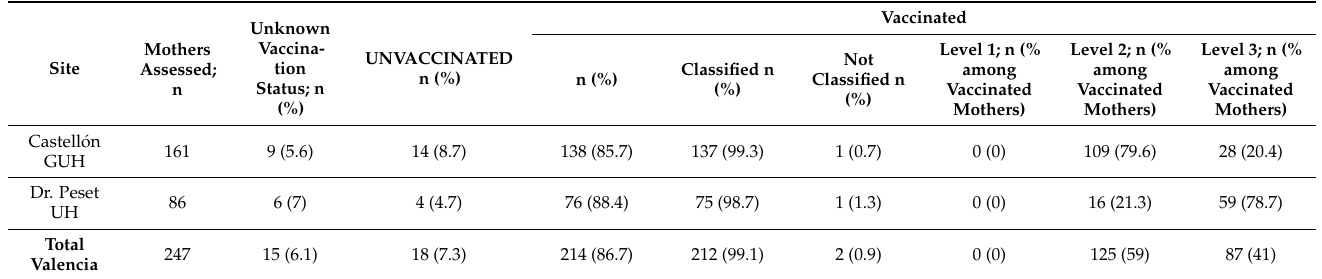
Table 7. Vaccination status among mothers of recruited cases during pregnancy, and diagnostic certainty level classification among the vaccinated mothers. % represents the percentage among assessed mothers unless explicitly